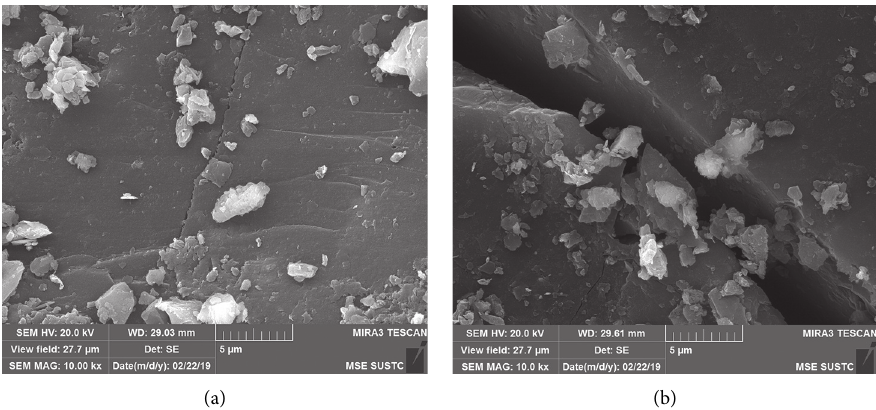
Figure 4: The microstructure of the coal sample. (a) Lvtang coal sample. (b) Quanlun coal